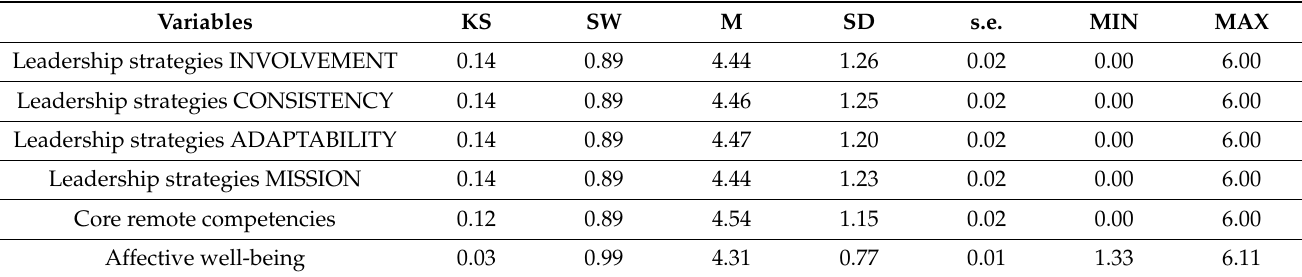
Table 2. The results of the normality of distribution and descriptive statistics.